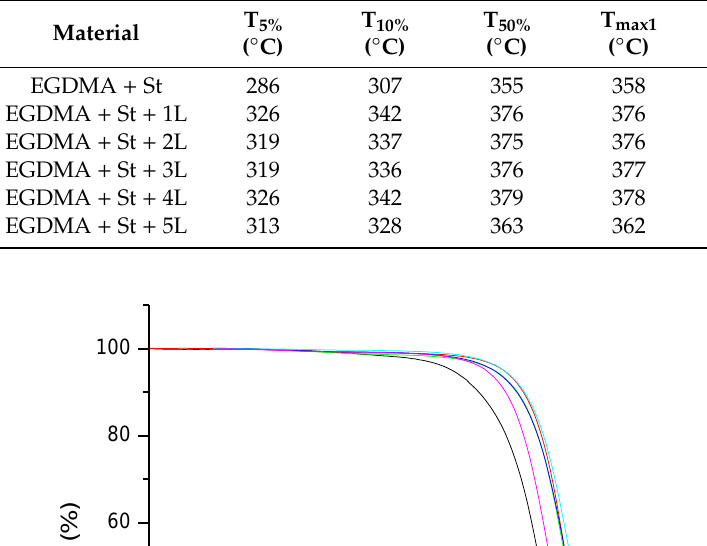
Table 5. Thermogravimetry data.